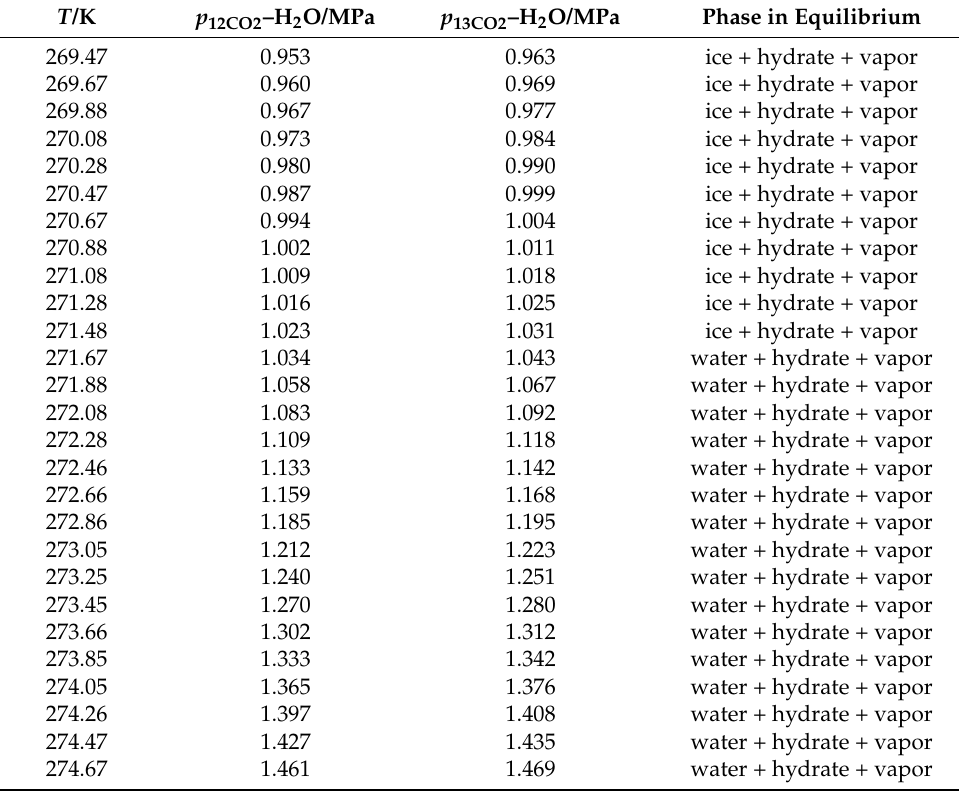
Table 2. Three-phase equilibrium p – T conditions in 12 CO 2 –H 2 O and 13 CO 2 –H 2 O systems a . T /K p 12CO2 –H 2